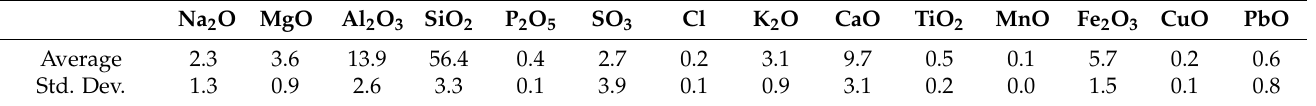
Table 4. SEM/EDX results in wt% for the studied clay bodies of tiles ( N =